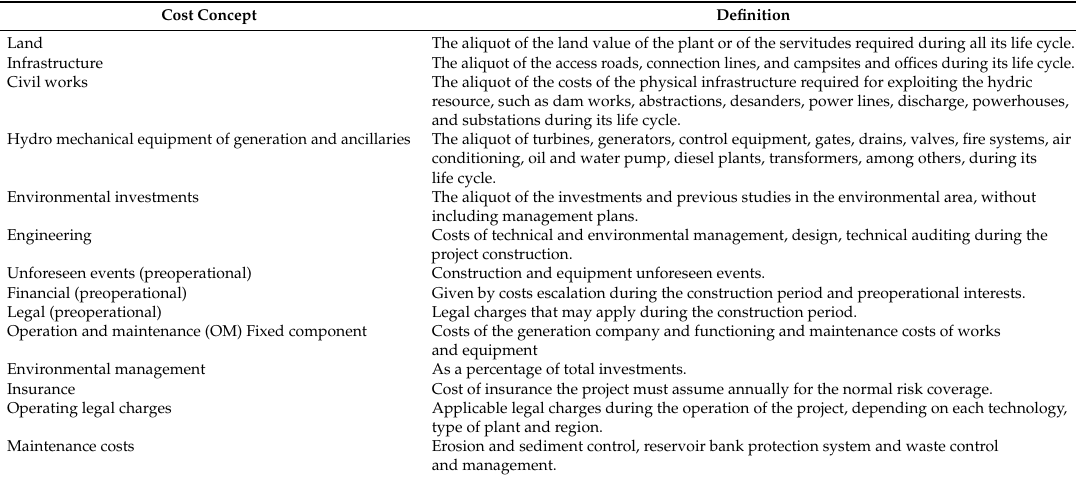
Table 1. Costs concepts of a hydroelectric plant dam.